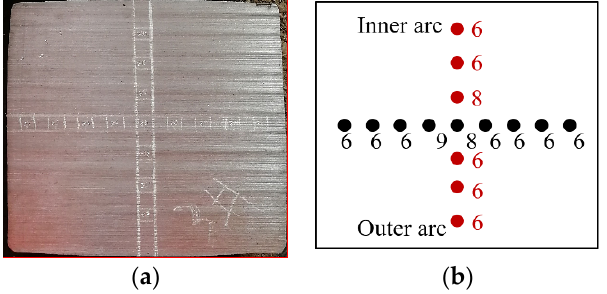
Figure 11. Total oxygen distribution in the cross-section from industrial result with M-EMS: ( a ) bloom test point; ( b ) total oxygen mass fraction, ppm.